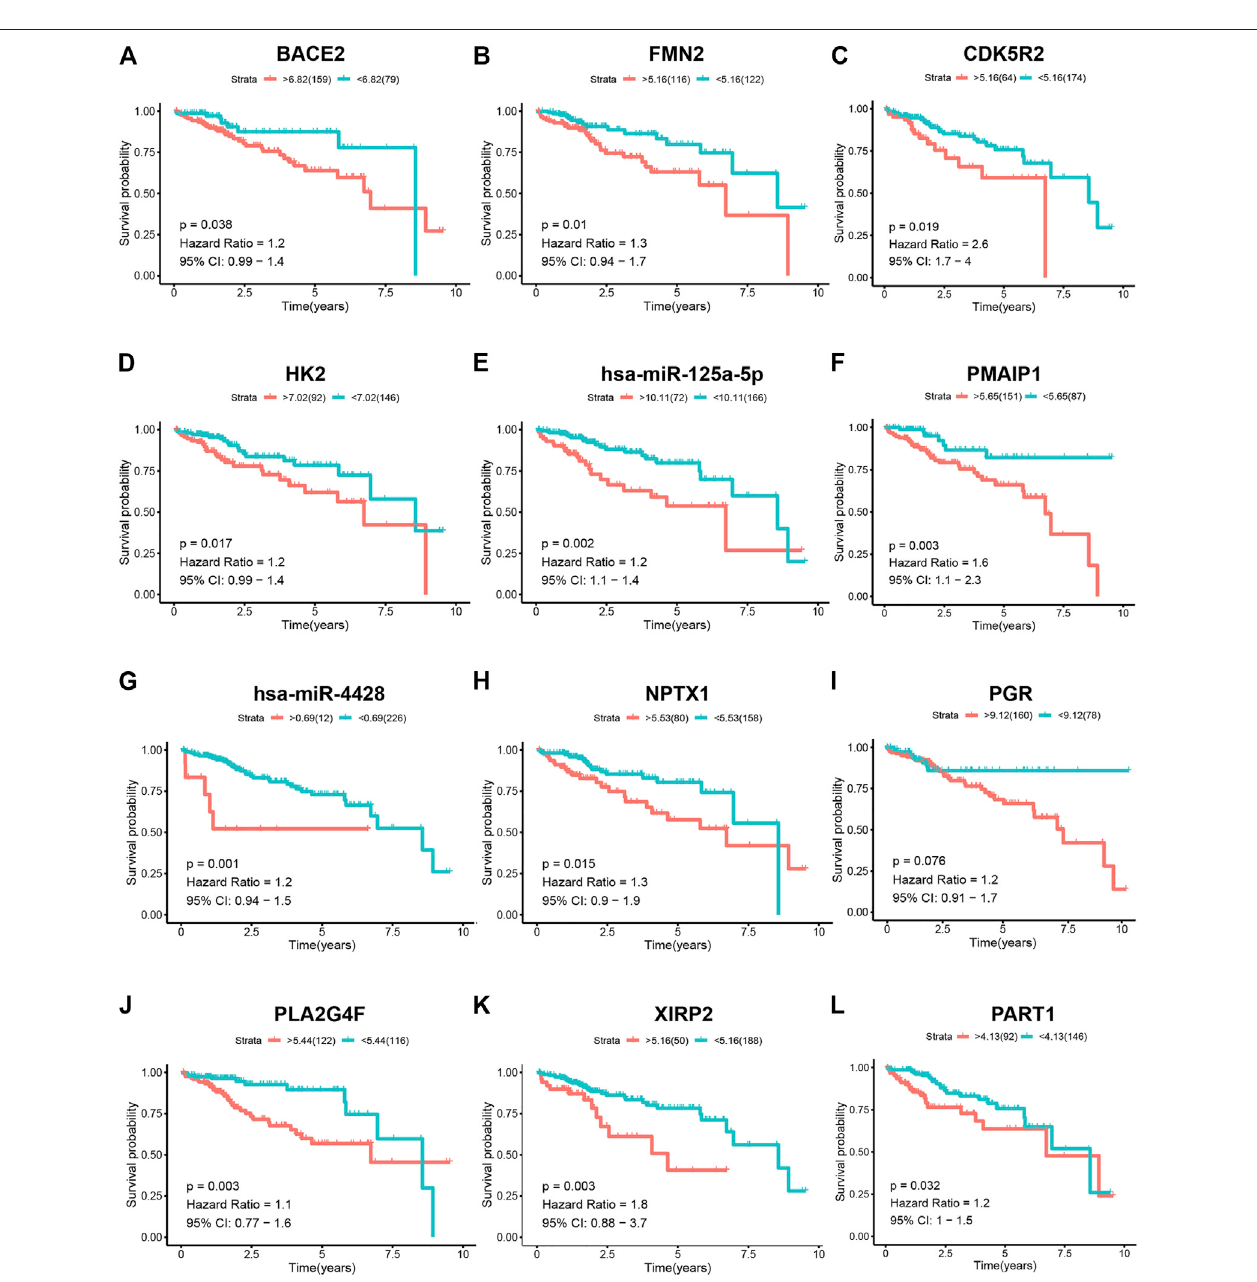
FIGURE4| K – Msurvivalanalysisofthecomponents oftheceRNAnetworkinpatientswithHCC. K – Msurvivalcurvesshowthat (A) BACE2( p =0.038), (B) FMN2 ( p =0.01), (C) CDK5R2( p =0.019), (D) HK2( p =0.017), (E) hsa-miR-125a-5p( p =0.002), (F) PAMIP1( p =0.003), (G) hsa-miR-4428( p =0.001), (H) NPTX1( p